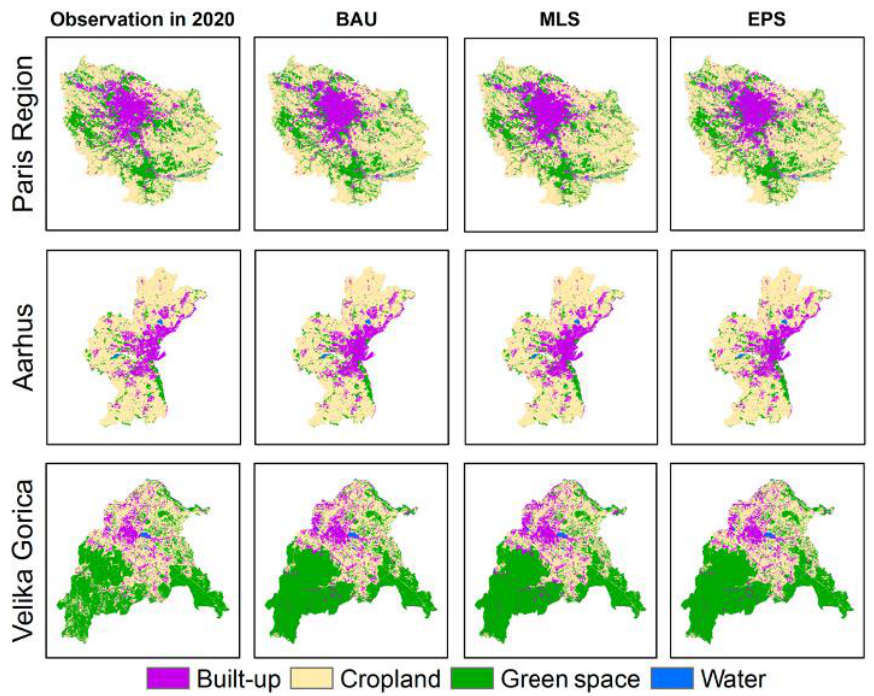
Figure 4. Land-cover observation results for 2020 and simulated land-cover maps for 2030 under three scenarios for three cities in Europe.